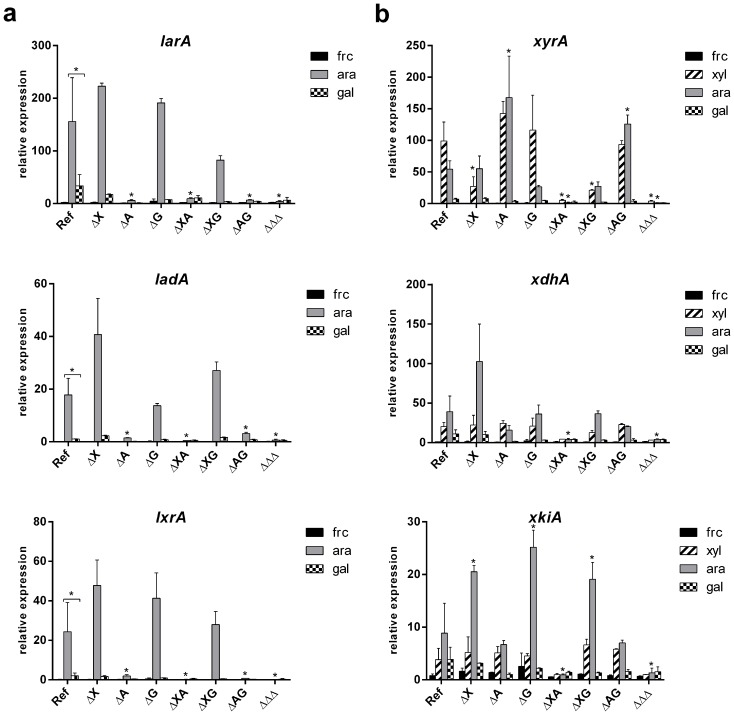
Expression levels of six genes encoding enzymes involved in the PCP in A. nidulans.The expression of larA, ladA, lxrA (a) and xyrA, xdhA, xki (b) was measured in the reference and regulatory mutant strains of A. nidulans after 2h of growth on D-fructose (black bars), L-arabinose (grey bars), D-xylose (striped bars) and D-galactose (checkered bars). The columns represent the mean and error bars represent standard deviation between biological replicates. Significant change in expression between the reference strain and the mutant was marked by the asterisk. The asterisk and the brace represent the significance between two indicated conditions.